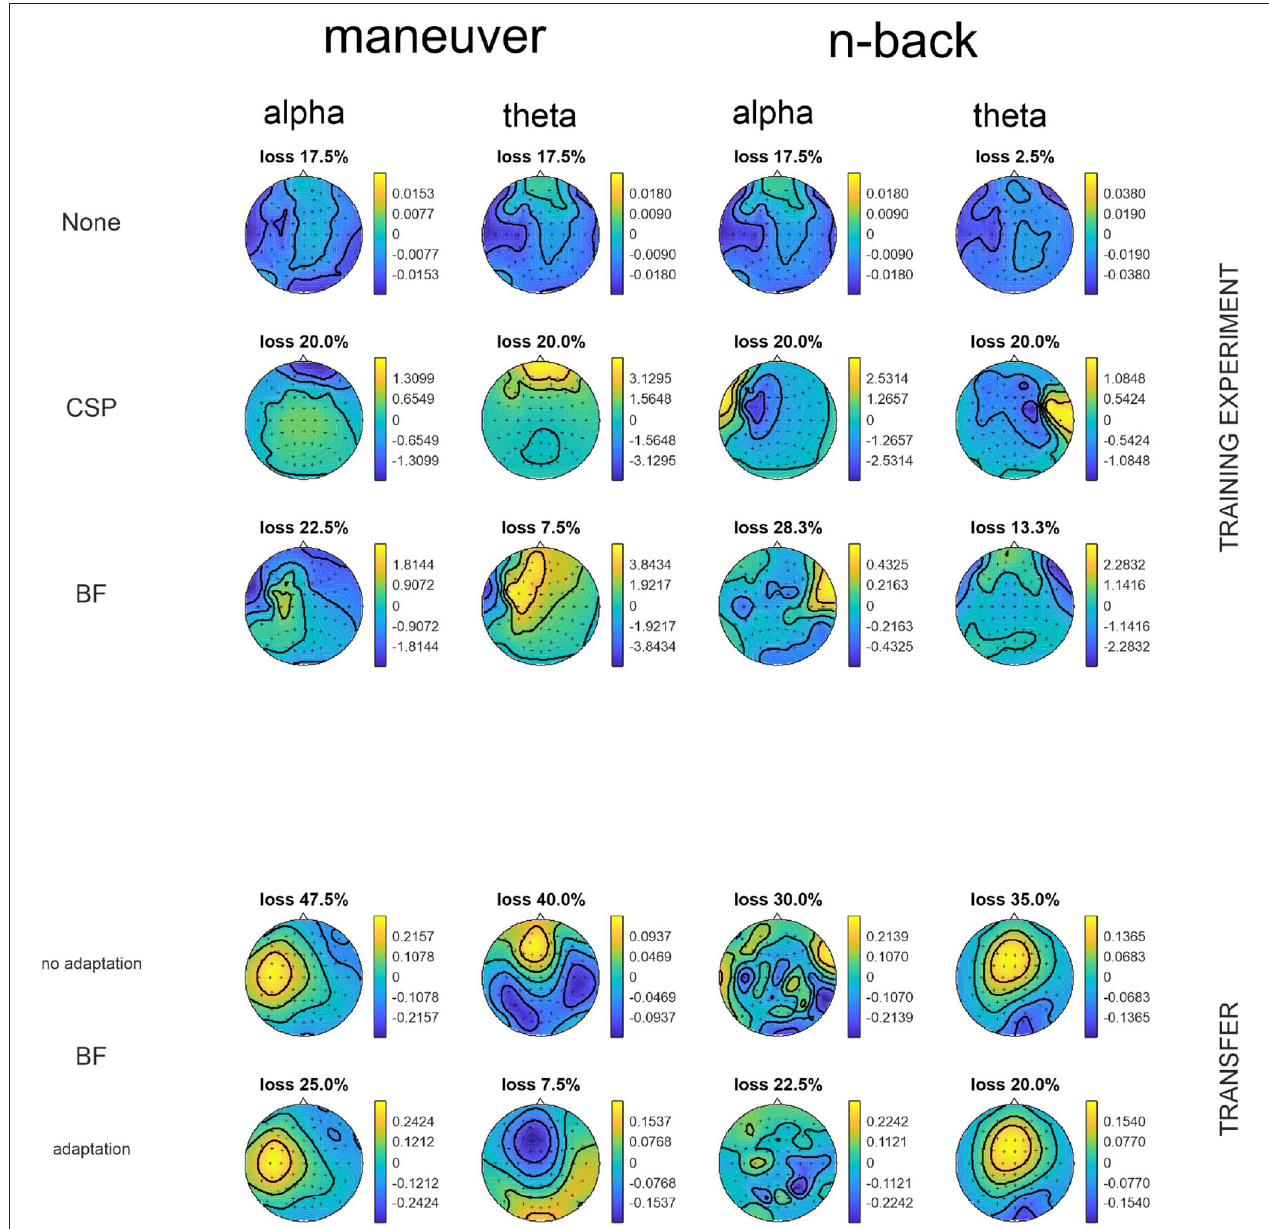
FIGURE 2 | The most discriminative patterns in the different frequency bands for exemplary subject 5. On top the data was cross-validated while on the bottom the respective transfer classes were trained on the other task and then applied with or without adaptation. For no filtering, the LDA classifier pattern is shown with the overall normalized loss, while in the other cases the spatial patterns with the lowest normalized loss with the corresponding normalized loss in single component classification. While No Filtering lead to the classifier picking a combination of different sources (brain, eyes, and muscles), CSP mainly sticked to eye artifacts for the maneuvering while in the n-back the resulting patters could originate from yaw muscles or temporal cortices. Small changes in the patterns lead to lower losses for the adapted BF. The non-adapted patterns stay similar to their original patterns, as the covariances do not change much (not shown). Here, mainly broad activation lead to the lowest loss. Adaptation can also drastically change the pattern (see alpha in n-back ) but mostly stays very similar (the flip in sign is meaningless).